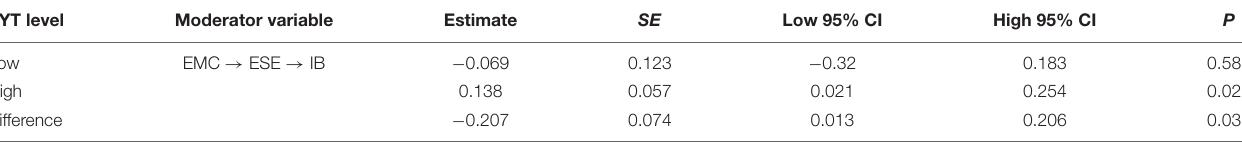
TABLE 5 | Bootstrapping estimates for mediated moderating